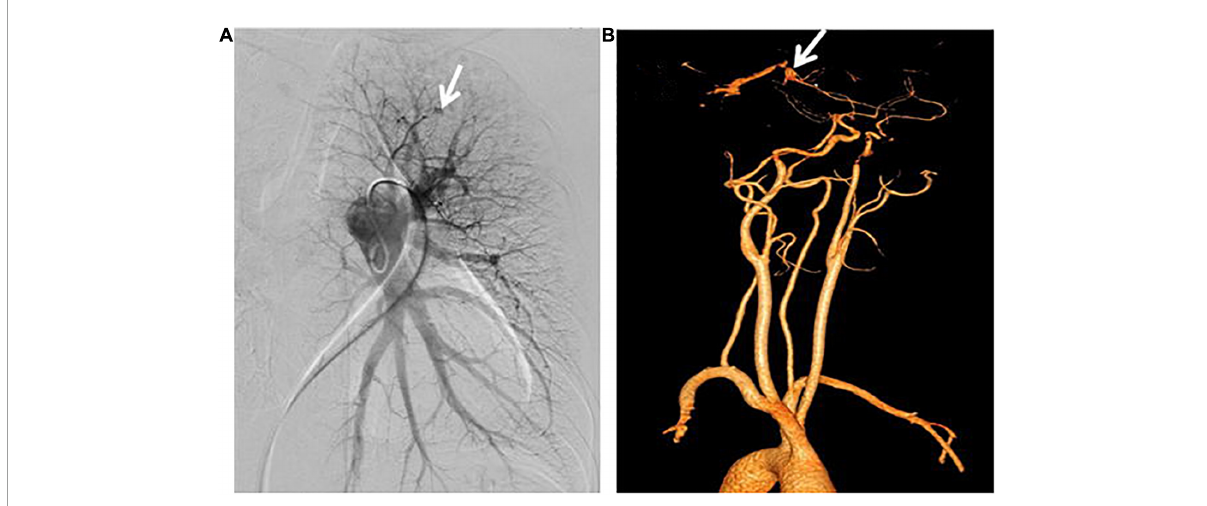
FIGURE3 Pulmonary angiography and cranial computed tomographic angiogram. (A) Arteriovenous malformations of the left upper pulmonary artery were shown. (B) Anterior cerebral artery malformations were